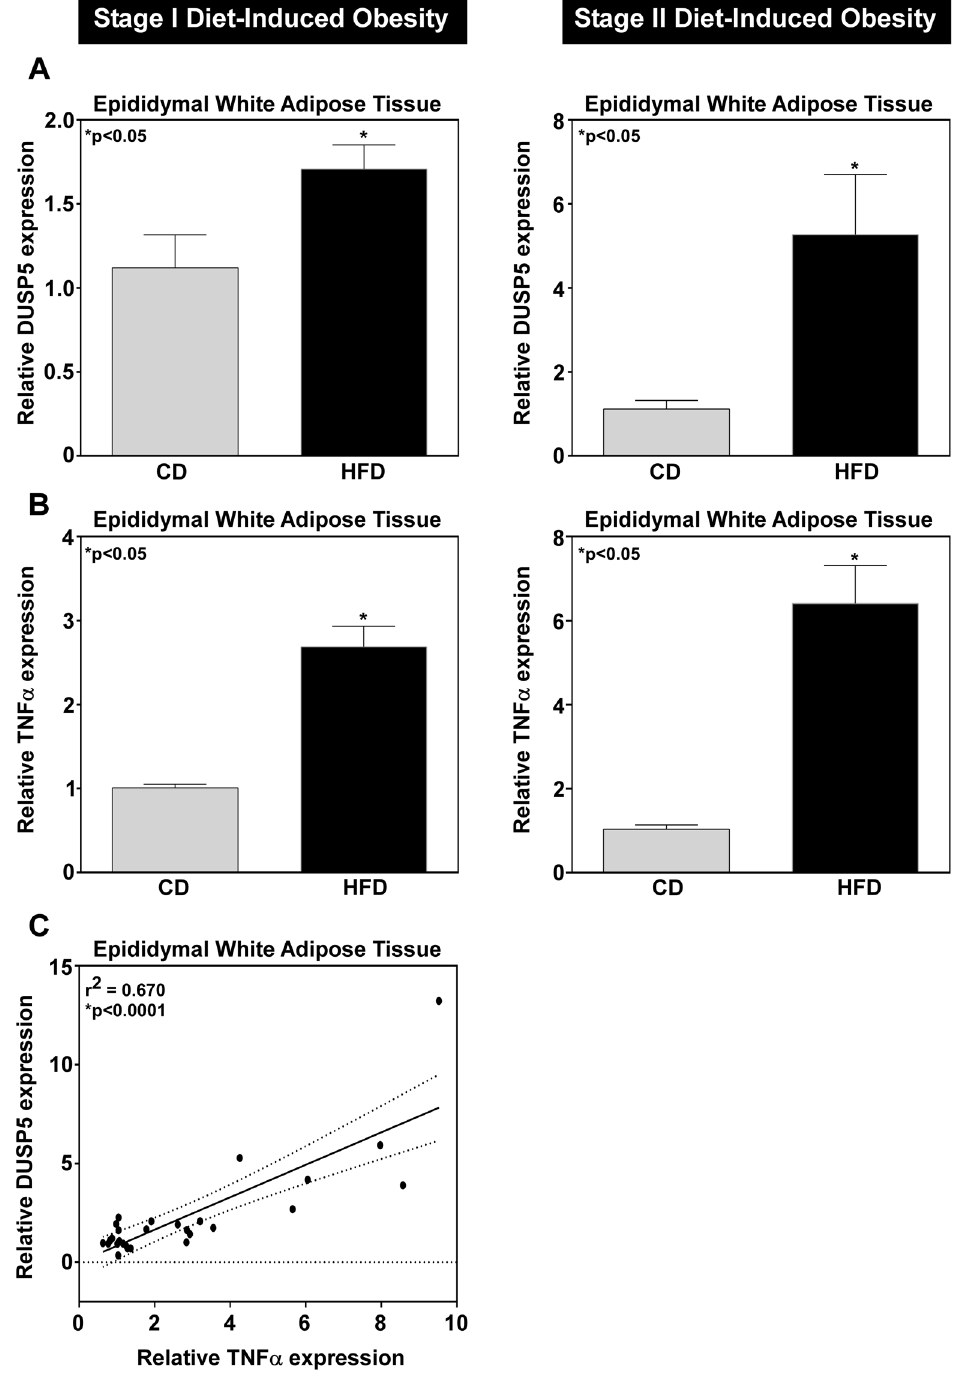
Figure 1. Increased DUSP5 mRNA expression correlates to increased obesity-mediated TNF α inflammation. RNA was isolated from white adipose tissue (WAT) and ( A ) DUSP5 and ( B ) TNF α mRNA expression assessed via qPCR. As the degree of obesity increased from stage I (12 wk HFD) to stage II (18 wk HFD), ( C ) TNF α mRNA expression increased; this correlated with increased DUSP5 message. Student’s t-test with Welch’s correction and Pearson Correlation were used to determine significance p <